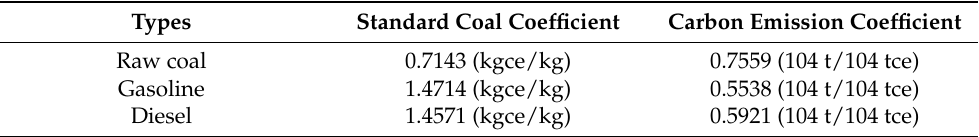
Table 2. Carbon emission factor for different types of fossil